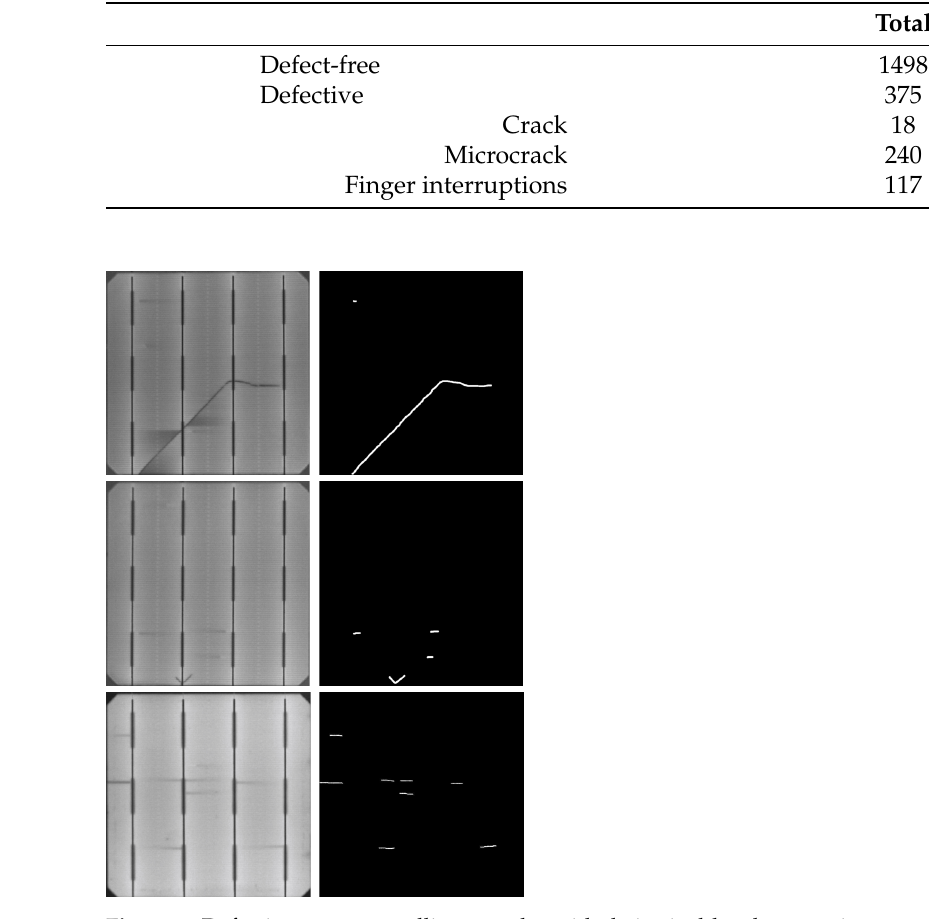
Figure 6. Defective monocrystalline samples with their pixel-level